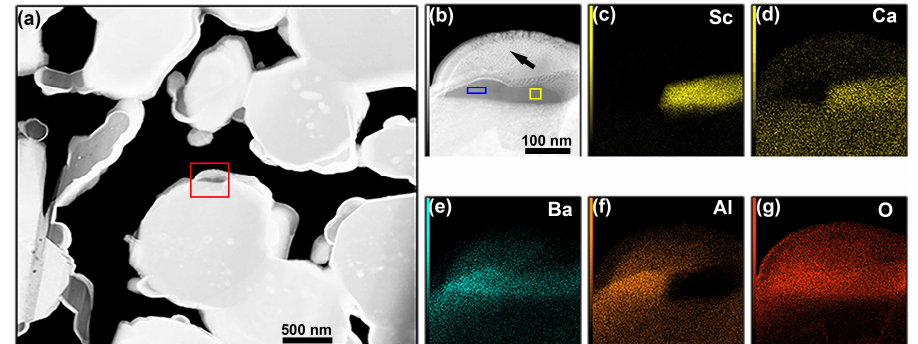
Figure 6. High spatial resolution EDS elemental mapping of Ba–Al oxide and adjacent Sc-containing particle. ( a ) Low-magnification HAADF image; ( b ) high-magnification HAADF image of area mapped by EDS, corresponding to red box in image ( a ), blue and yellow boxes denote locations of EDS point analysis; ( c – g ) elemental maps of Sc, Ca, Ba, Al and O; ( b – g ) share the same scale